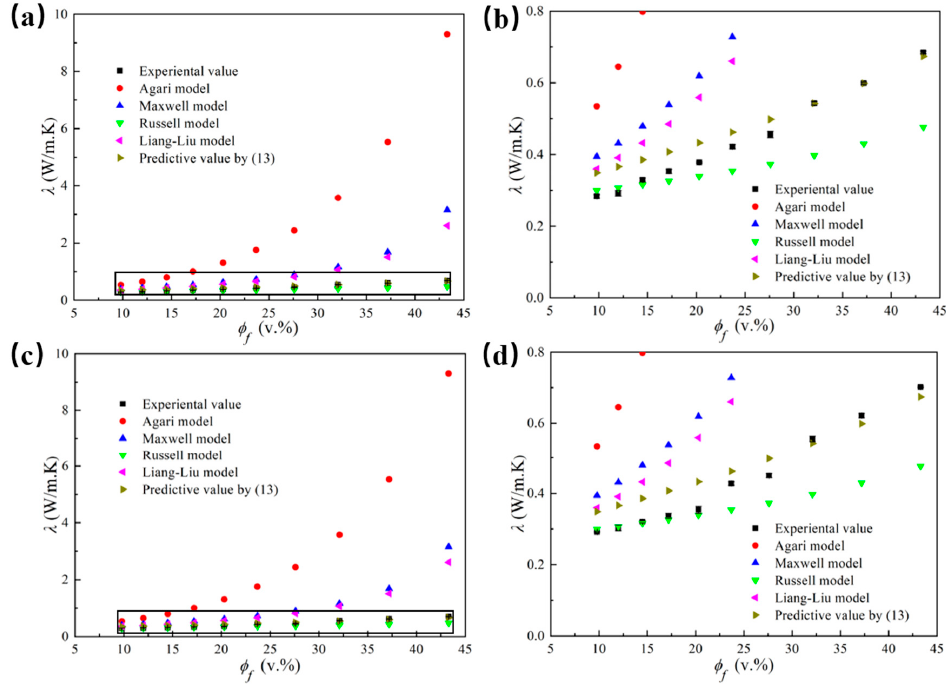
Figure 10. The thermal conductivity of LLDPE/Al 2 O 3 composites with different Al 2 O 3 diameters obtained from prediction model and experiment versus the volume fractions of Al 2 O 3 particles: ( a , b ) for 5 μ m; ( c , d ) for 40 μ m.